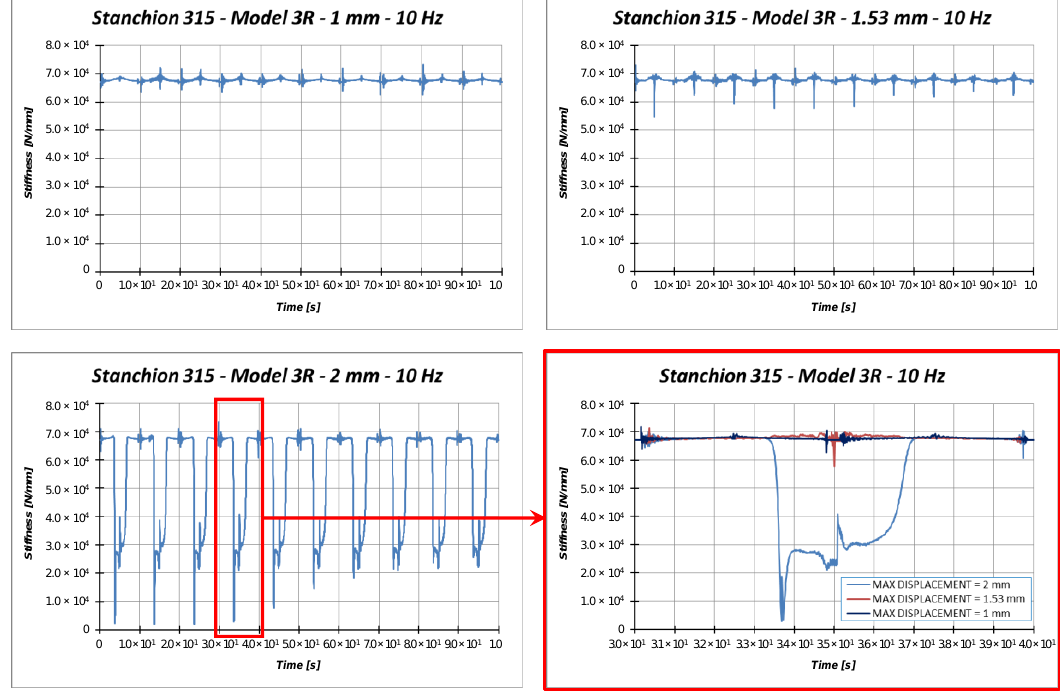
Figure 17. Model 3R: Stiffness comparisons.